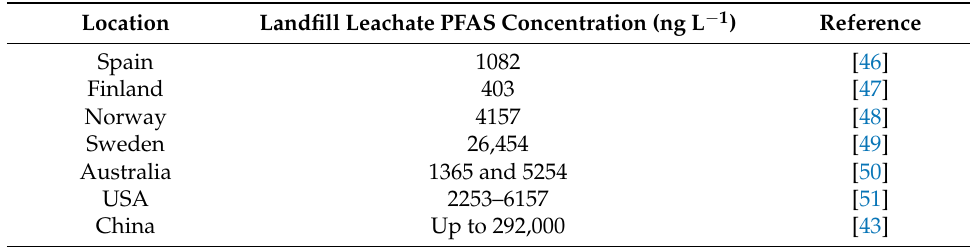
Table 1. PFAS concentrations in Landfill